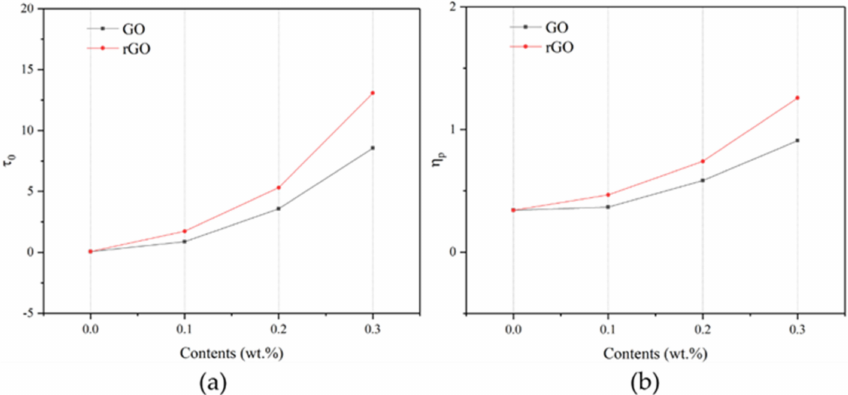
Figure 9. Variations between rGO and GO samples’ yield stress ( a ) and plastic viscosity ( b ).